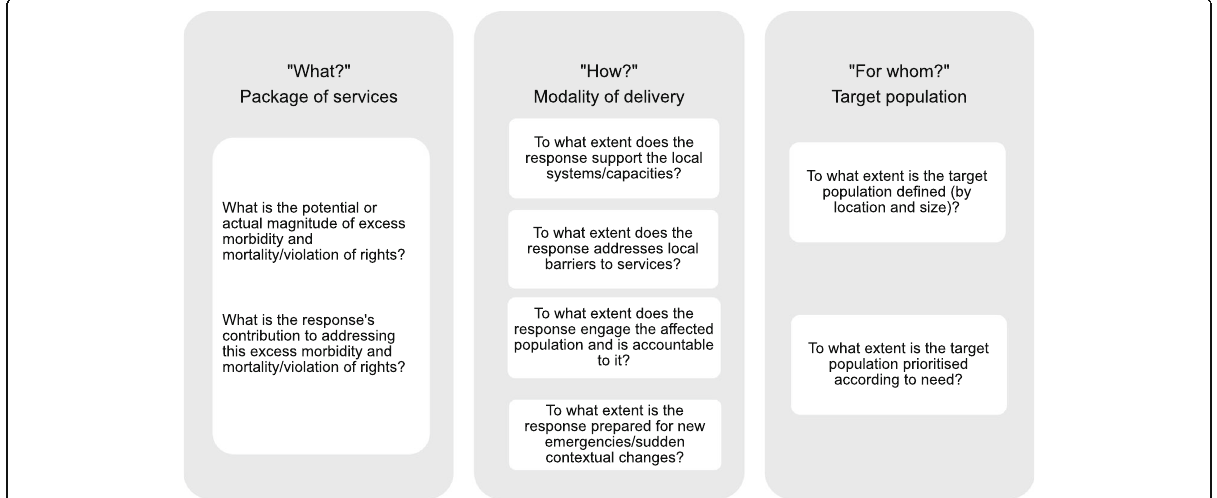
Fig. 1 A proposed conceptual framework for assessing the appropriateness of humanitarian